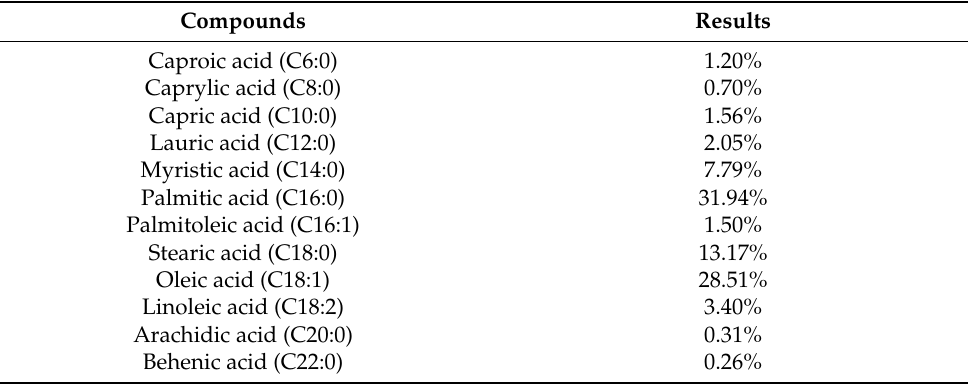
Table 2. Lipids composition of the lyophilized liquor produced from fermented shrimp waste.